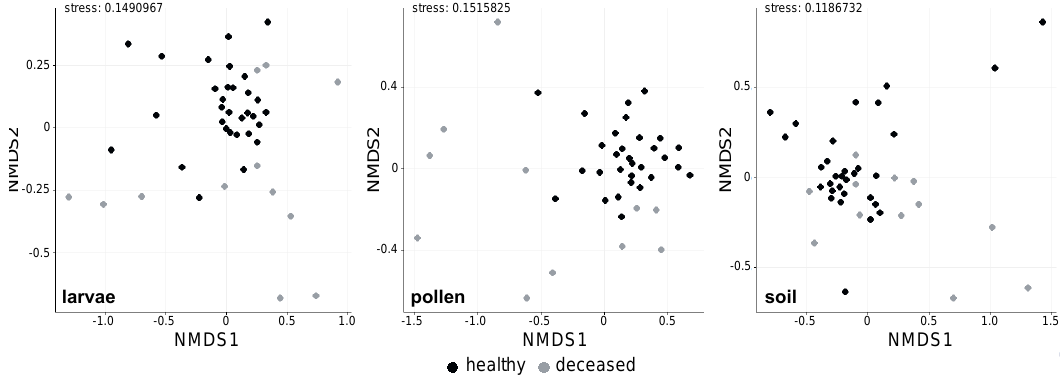
Figure 2. Bray–Curtis-based non-metric multidimensional scaling (NMDS) ordinations of larvae, pollen, and soil pellets acquired from O. bicornis nest chambers, where 31 contained healthy larvae and 12 contained deceased larvae.